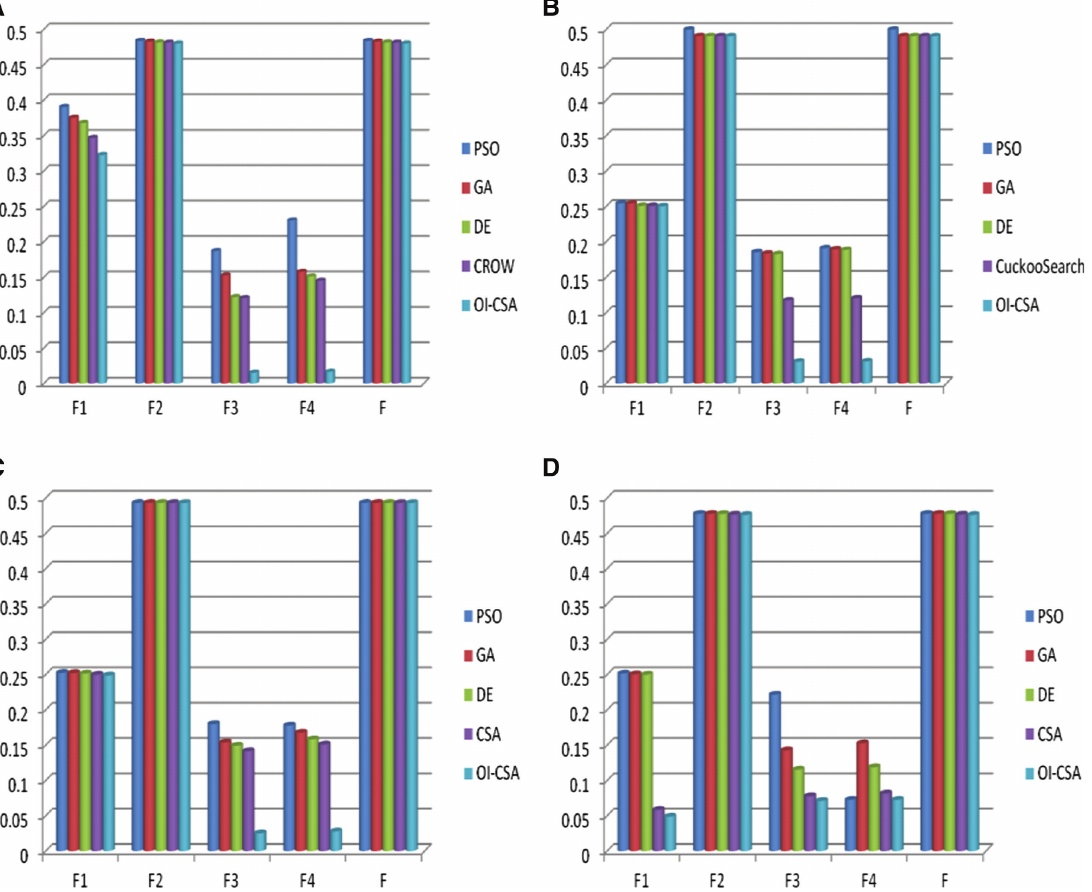
Figure 5: Performance Analysis of the Proposed and Conventional Approaches for Data Preservation Algorithm Using Satabase (A) Chess, (B) Retail, (C) T40 and (D)